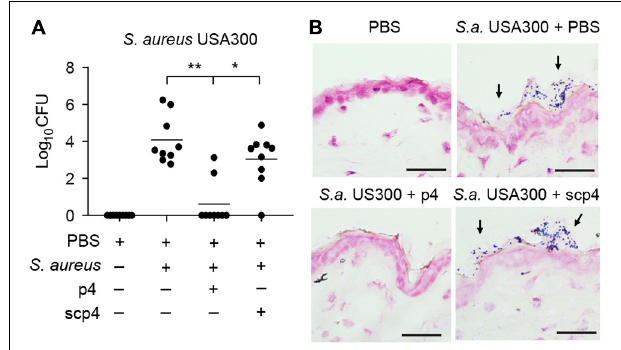
FIGURE 4 | p4 is effective against MRSA in the experimental model of skin infection. (A) WT mice were treated with vehicle (PBS) or ectopically infected with 1 × 10 7 CFU of S. aureus USA300 in the presence of 100 µ M p4, control peptide scp4, or PBS. Data points indicate the number of live bacteria recovered from the skin surface 24 h after application of MRSA, with each data point representing one cavity and a horizontal line indicating the mean value in each group; n = 6. ** p < 0.01; * p < 0.05 by the Kruskal–Wallis test with post hoc Dunn’s multiple comparisons test. (B) Mice were treated as in (A) followed by Gram staining. S. aureus on the skin surface is indicated by arrows . Scale bar = 20 µ m.